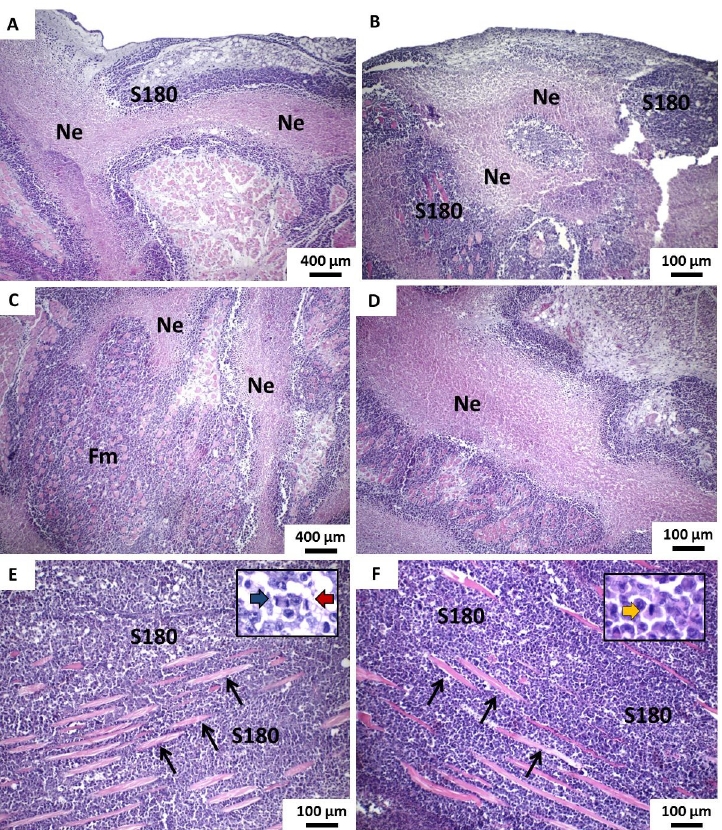
Figure 8. Photomicrographs of HE stained histological sections show the main histopathological features of tumors developed in groups β -CD:POH (100 and 200 mg/Kg) from the implantation of S180 cells. ( A , B ) Irregular tumor boundaries and areas of peripheral coagulative necrosis and ( C , D ), as well as extensive blocks of necrosis in the most central areas of the tumor masses observed in groups β -CD:POH 100 mg/Kg and 200 mg/Kg, respectively (100×). ( E ) Intense dissociation of muscle fibers by tumor cells in both groups β -CD:POH 100 mg/Kg and ( F ) β -CD:POH 200 mg/Kg (100 × ). In the details, there are figures of mitosis in different phases of the cell cycle (400×). Legend: S180—Viable tumor cells of sarcoma 180; Coagulative necrosis; Thin black arrows—striated skeletal muscle fibers; Blue arrow—anaphase mitosis; Red arrow—metaphase mitosis; Orange arrow—prophase mitosis.